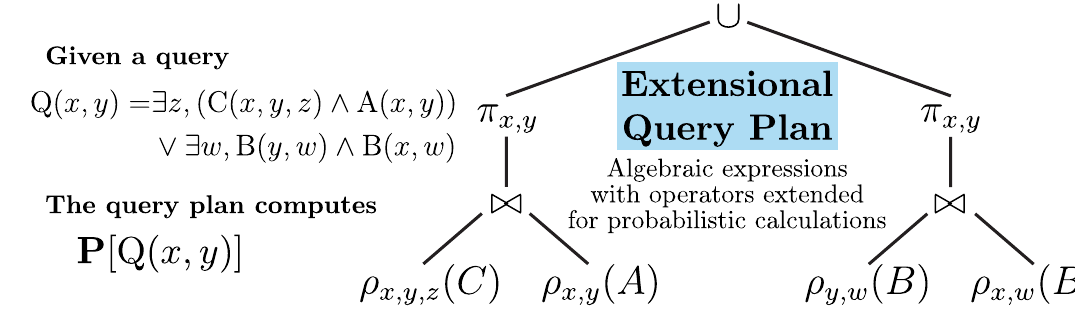
Figure 9. An extensional query plan solves P [ Q ] for a given query Q by using algebraic operations that are extended with probabilistic calculations 14 . Symbols ρ , π and ⊲⊳ refer to the operations of rename , projection and natural join as they are used in database theory, specifically in relational algebra 25